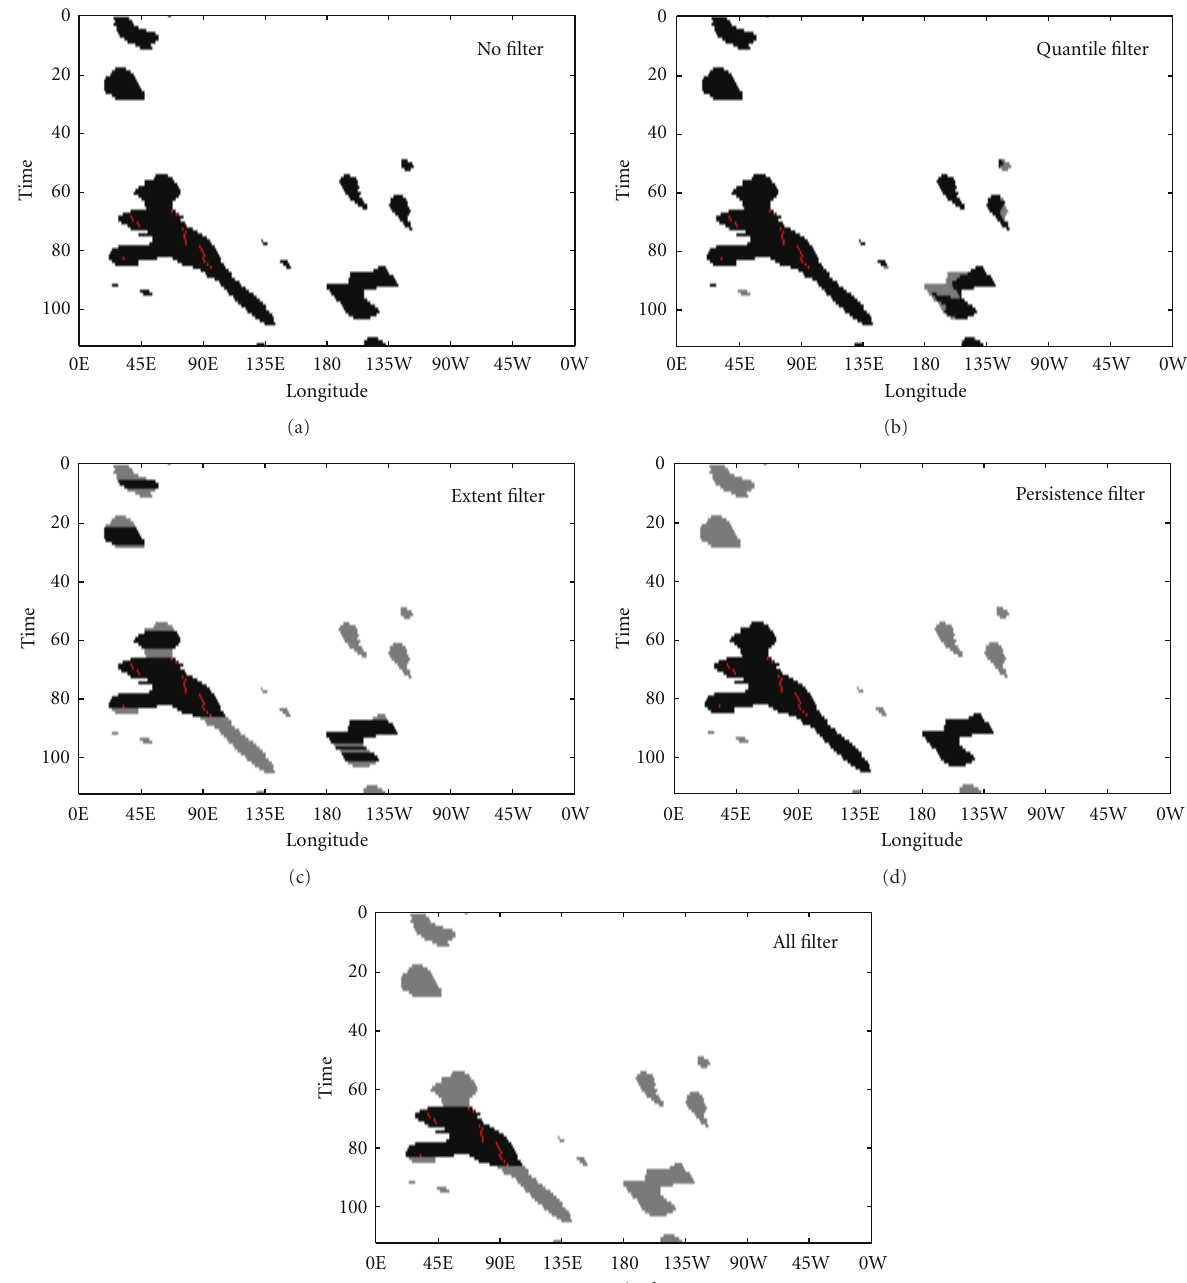
Figure 13: Hovm¨oller diagrams showing blocked longitudes for 6h timescales and 112 time steps for February 1990 with blocked areas (black) and filtered areas (grey). The red marks indicate the center of the block (highest GHGS): (a) no filter, (b) quantile filter only, (c) extent filter only, (d) persistence filter only, and (e) all